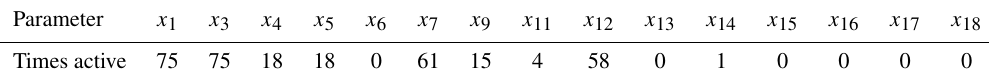
Table 4. Number of outputs for which each parameter was judged active (and hence included in the emulator for that output). Recall that x 7 and x 8 are linked, and so x 8 is not present in the table, and similarly for x 10 which is linked to x 9 . Also x 2 is used only for the thin-layer source